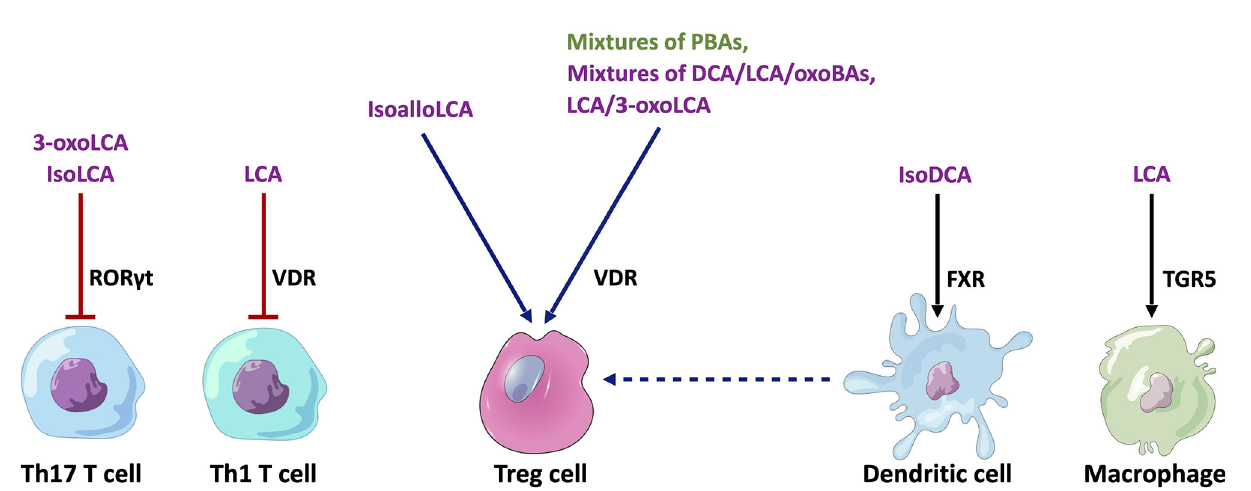
FIGURE 3 | Cell type-speci fi c effects of BAs on immune cell populations relevant to IBD. Mixtures of PBAs (CA/UDCA, CDCA/UDCA or CA/CDA/UDCA) or SBAs (DCA/LCA/3-oxoCA/3-oxoLCA/7-oxoCA/7-oxoCDCA/12-oxoCA/12-oxoDCA or LCA/3-oxo-LCA) have been found to stimulate ROR g t + FOXP3 + Treg cells by acting on the VDR in mice (N.B. In mice, UDCA is considered to be a PBA). IsoalloLCA can stimulate the differentiation of FOXP3 + Treg cells through an epigenetic pathway. 3-oxoLCA and isoLCA inhibit the differentiation of Th17 T cells by acting on the ROR g t receptor, whilst LCA inhibits Th1 T cell differentiation through a VDR-dependent mechanism. IsoDCA induces an anti-in fl ammatory pro fi le in DCs by acting on the FXR, which leads to the promotion of ROR g t + FOXP3 + Treg cells. Similarly, LCA induces an anti-in fl ammatory phenotype in macrophages by activating TGR5. Purple text - SBAs, Green text - PBAs, Blue arrows - stimulatory interactions, Red arrow - inhibitory interaction, Black arrow - anti-in fl ammatory effect. PBAs, primary bile acids; SBAs, secondary bile acids; DCA, deoxycholic acid; LCA, lithocholic acid; ROR g t, Retinoic acid-related orphan receptor gamma t; VDR, vitamin D receptor; FXR, farnesoid X receptor; TGR5, Takeda G protein-coupled receptor